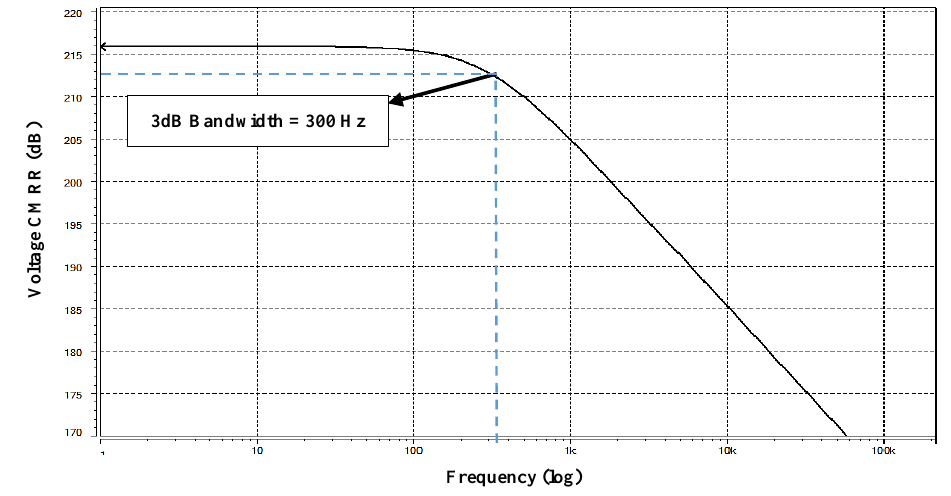
Figure 5. Voltage CMRR for proposed CMIA with RL=1 KΩ, 𝑹′